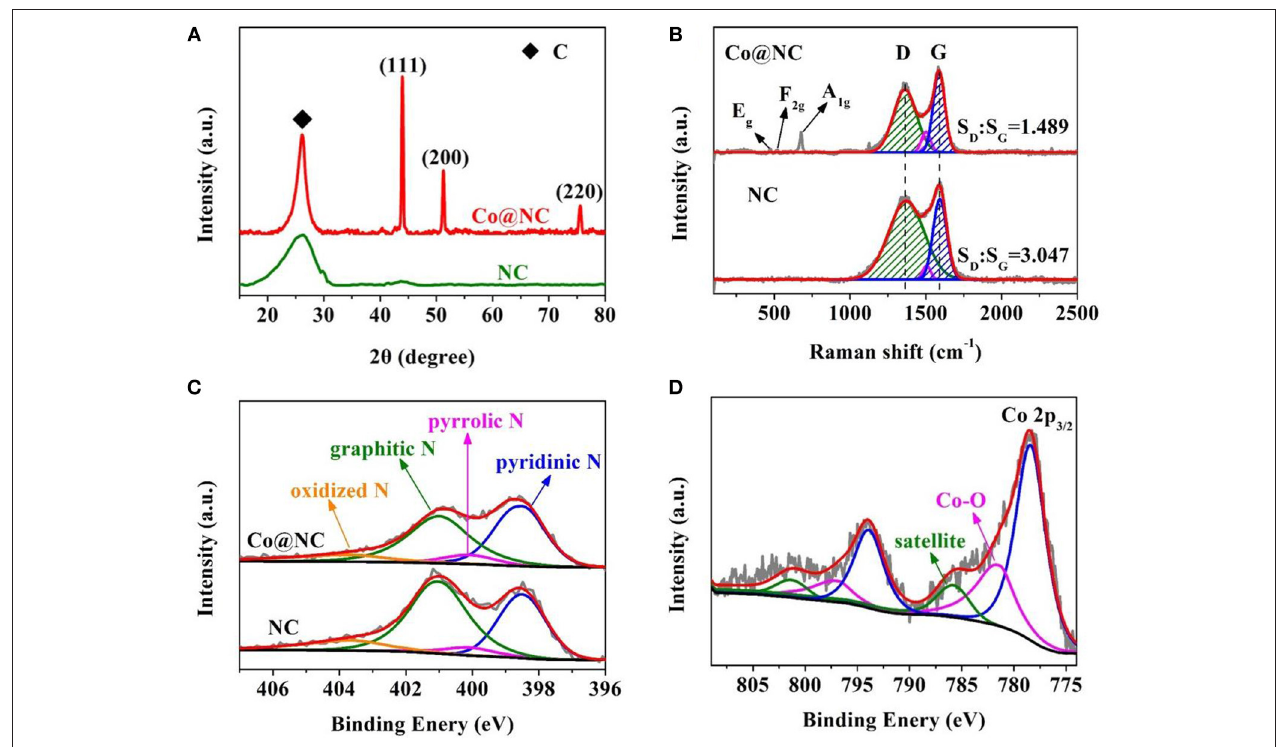
FIGURE 2 | (A) XRD patterns, (B) Raman spectra of NC and Co@NC. The high resolution spectrum of (C) N1s of NC and Co@NC. (D) The high resolution Co2p spectrum of